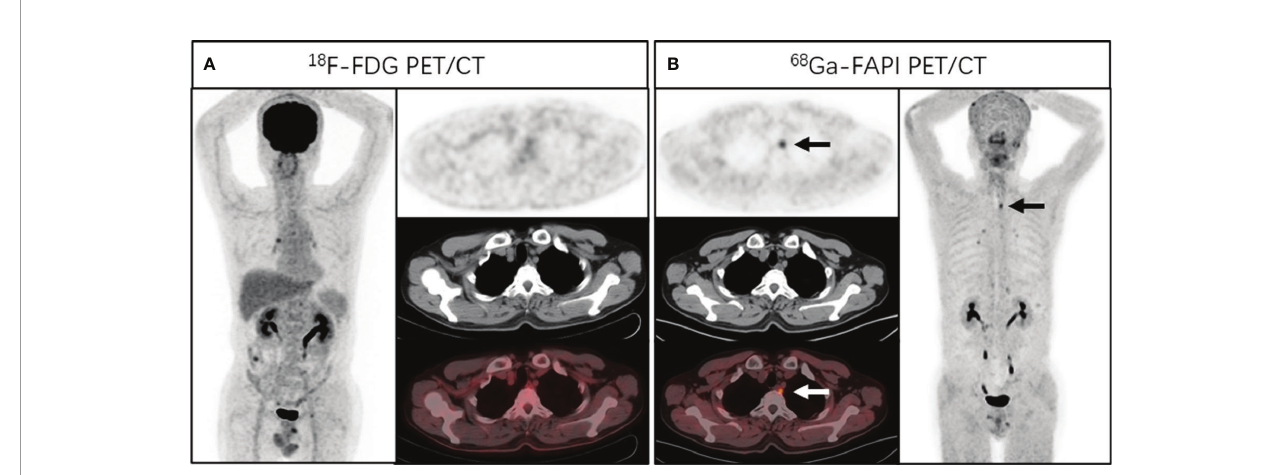
FIGURE 1 | A 58-year-old man presented with a complaint of progressive dysphagia and back pain for 2 months. Endoscopic biopsy demonstrated a well- differentiated squamous cell carcinoma of the upper esophagus. Chest CT and [ 18 F]FDG PET/CT (A) showed no abnormal density and activity in esophagus. [ 68 Ga] Ga-DOTA-FAPI-04 PET/CT (B) revealed a focus of intensive uptake in the upper esophageal cancer (arrows, SUVmax of 3.4); no other foci of [ 68 Ga]Ga-DOTA-FAPI- 04 uptake associated with esophageal cancer were seen. Subsequently, the patient received radical radiotherapy plus chemotherapy.